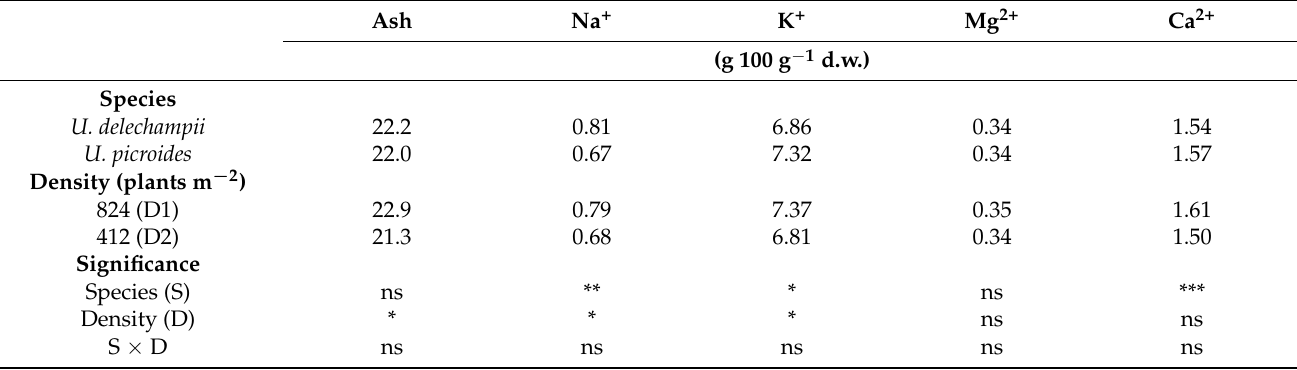
Table 3. Ash and cation content of smooth golden fleece ( U. delechampii ) and prickly golden fleece ( U. picroides ) grown in a floating system at two sowing densities (first harvest).